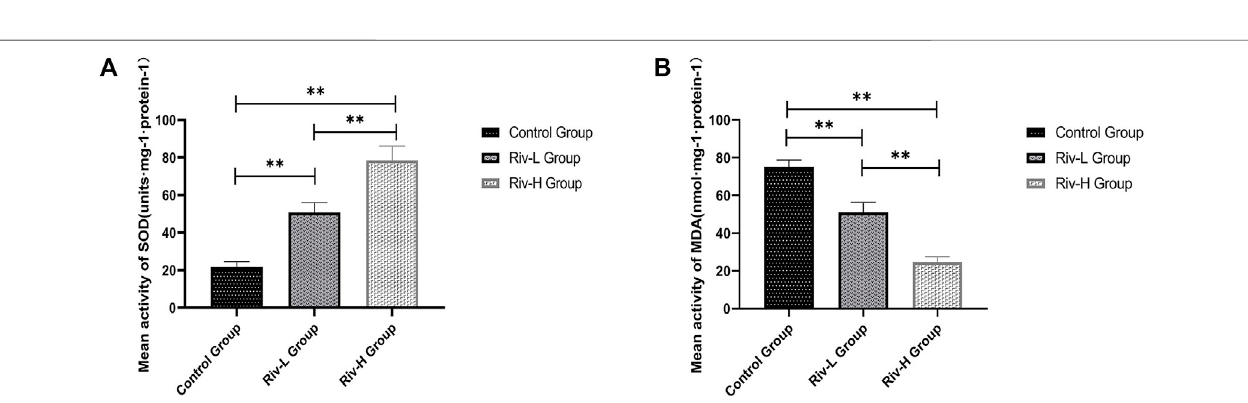
FIGURE 4 |(A) Average SOD activities in rat skin fl ap tissue. (B) Comparison of average MDA contents in rat skin fl ap tissueamong groups. Rivastigmine reduced oxidative stress. Compared to the control group, low and high doses of rivastigmine resulted in signi fi cant changes in SOD and MDA. There were also signi fi cant differences between the Riv-L and Riv-H groups. ** p <